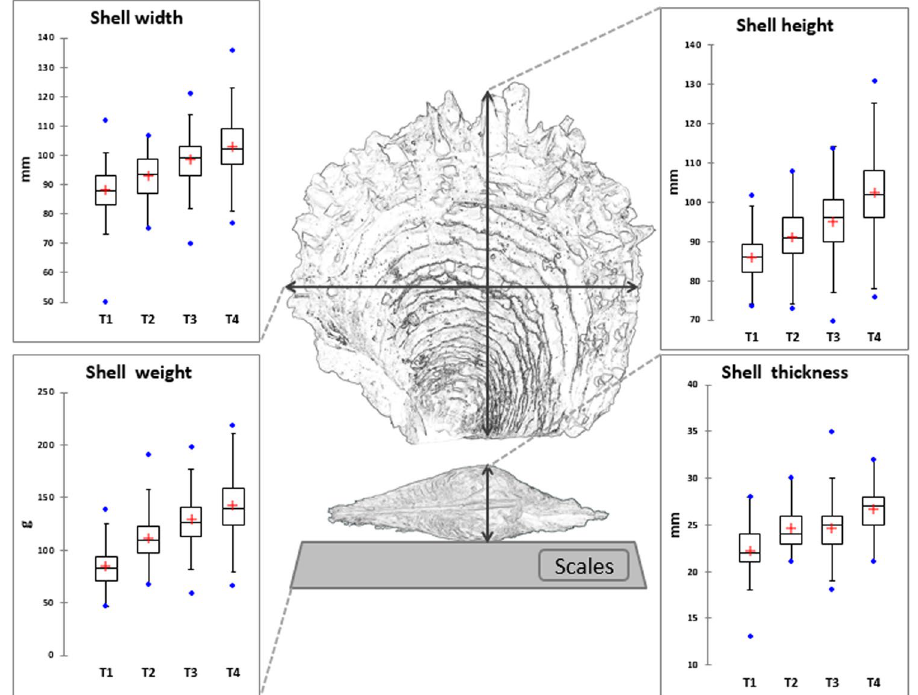
Figure 5. Pinctada margaritifera recipient oyster shell biometric parameters measured at each harvest time (T1 corresponds to 3 months of culture, T2 to 6 months, T3 to 9 months and T4 to 12 months of rearing): shell width, height, thickness, and the total oyster weight (soft tissue parts + shells). Each box-plot has the following 6 elements: 1) mean (“ + ” cross in the box-plot); 2) median (solid bar in the box-plot); 3) 25 th to 75 th percentile (rectangular box); 4) 1.5 * interquartile range (non-outlier range of the box whiskers); 5) minimum and maximum values (extreme dots); and 6) outlier values (outside box whiskers) (N =